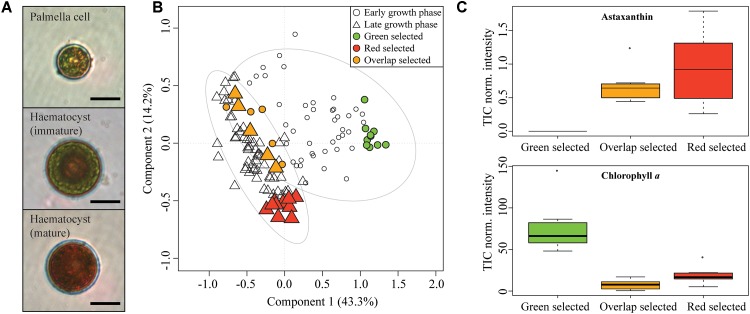
(A) Microscopy observations of a palmella cell (green stage), immature and mature haematocyst (red stage). Scale bar 10 μm. (B) PLS-DA score plot of LSC-MS profiles of H. pluvialis cells in early and late growth stage. The ellipses represented the 95% confidence region estimated by the statistical calculation. (C) Comparison of pigments content (represented as TIC normalized intensity) in selected group of LSC-MS spectra of red, green and overlap cells.